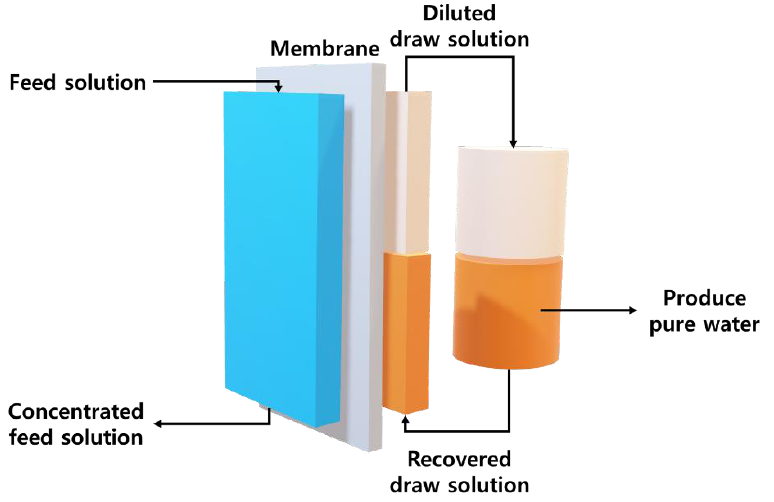
Figure 1. Schematic diagram of forward osmosis (FO) process.